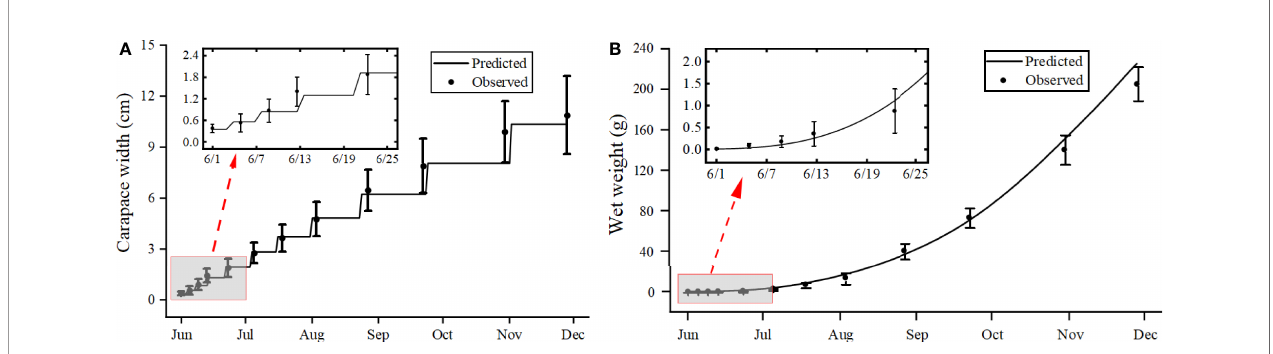
FIGURE 1 | Comparison of observations (circles with bars for standard deviation) and simulations (lines) of carapace width (A) and wet weight (B) of the swimming crab Portunus trituberculatus .